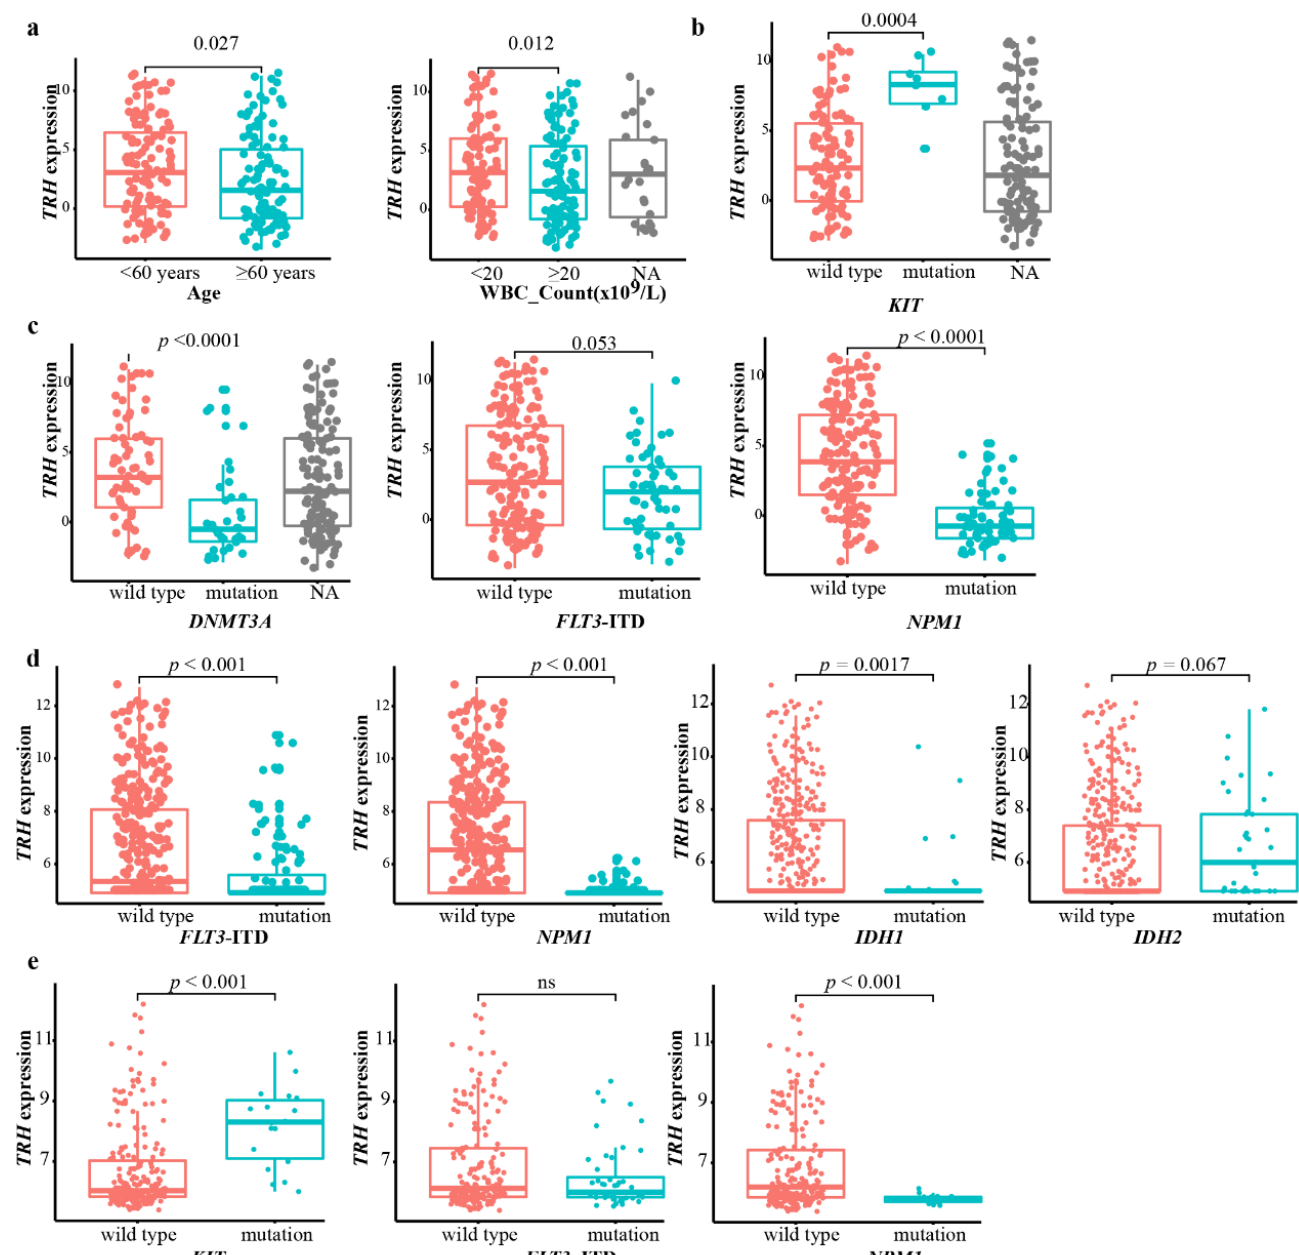
Figure 4. Clinical and genetic correlation with TRH expression in Beat AML, GSE6891, and GSE17855 datasets . ( a ) Comparison of TRH expression in different clinical subgroups in the Beat AML dataset. ( b ) Comparison of TRH expression in KIT –wild type and KIT –mutation groups from Beta AML. ( c ) Comparison of TRH expression in wild-type and mutation groups of DNMT3A , FLT3 - ITD, and NPM1 in Beat AML. ( d ) Comparison of TRH expression in different genetic subgroups of the GSE6891 dataset. ( e ) Comparison of TRH expression in different genetic subgroups of the GSE17855 dataset. Statistical significance was determined using the Wilcoxon test.